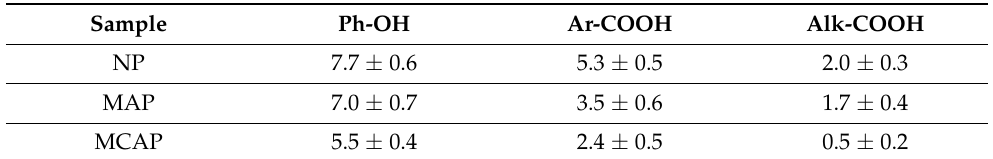
Table 4. The content of phenolic and carboxyl groups in the peat samples according to reverse potentiometric titration, mmol/g.